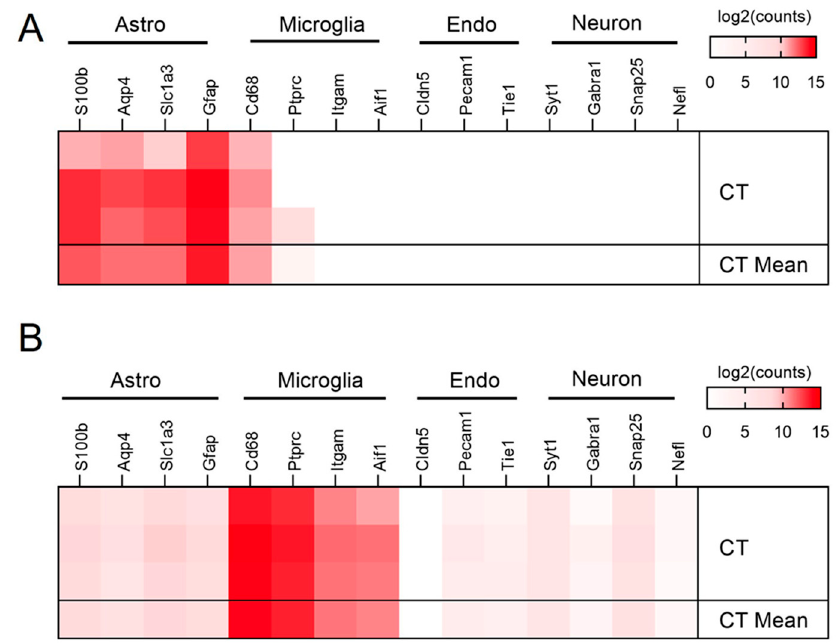
Figure 2. RNA sequence validation of the primary astrocyte and microglia cultures. Cell purity heatmaps depict gene counts for cell-type-specific markers for astrocytes (Astro), microglia, endothelial cells (Endo), and neurons in primary cultures of astrocytes ( A ) and microglia ( B ).